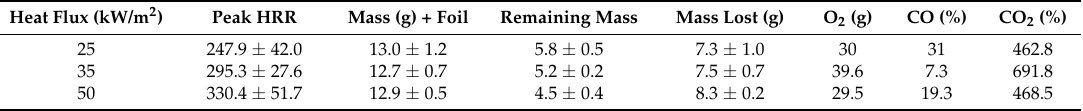
Table 1. Combustion variables of vinyl measured using a cone